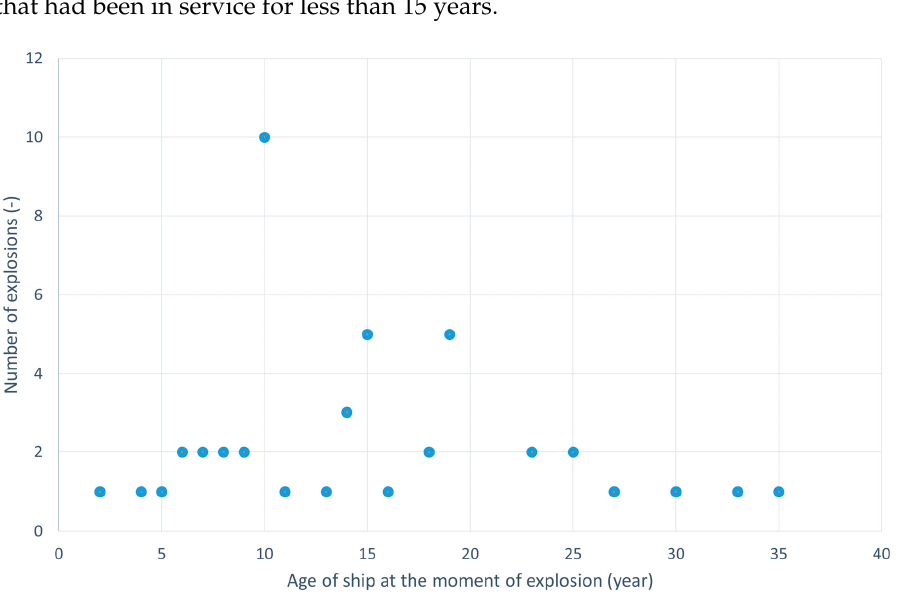
Figure 10. Number of main engine turbocharger explosions as a function of the ship’s age. Figure 11 shows the number of explosions by ship type. The largest number of explosions occurred on product tankers/ore/oil, with seven explosions, followed by passenger/Ro-Ro and general cargo ships, both with six explosions in each group. In third